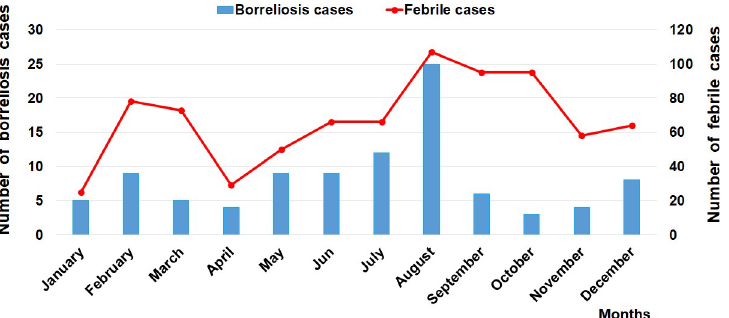
Fig 5. Monthly variation in visits of febrile cases and the prevalence of borreliosis cases diagnosed in the Niakhar district.